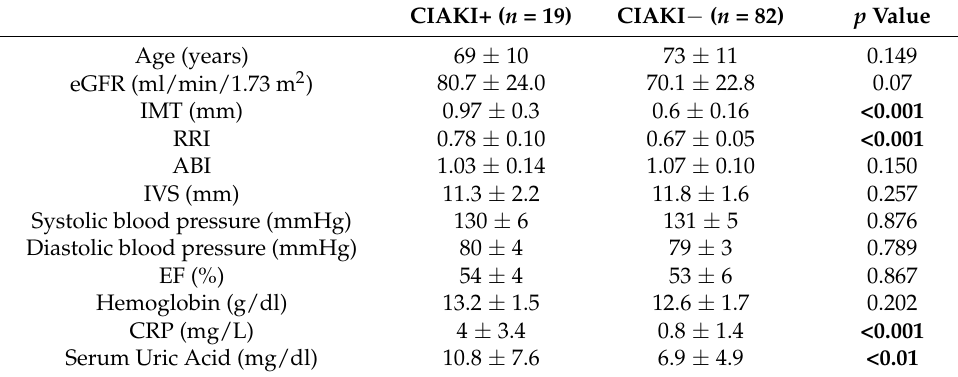
Table 2. Comparative analysis of demographic and clinical characteristics of patients with and without CIAKI. Data are shown as mean ± standard deviation or number (%). In bold are reported significant